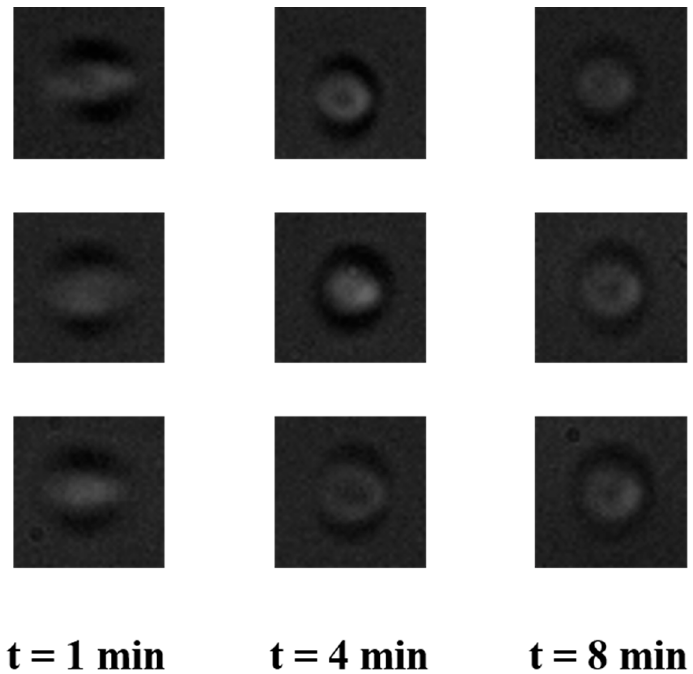
Figure 6. Representative images of red blood cells (RBCs) in the flow in a microfluidic device at different times after the start of pumping. The images are out of focus due to the larger depth of the channel that was used for imaging.